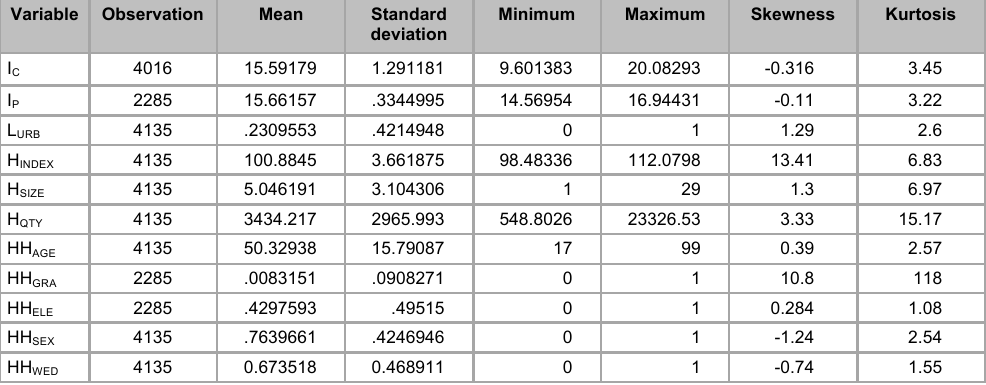
A description of owner occupier in